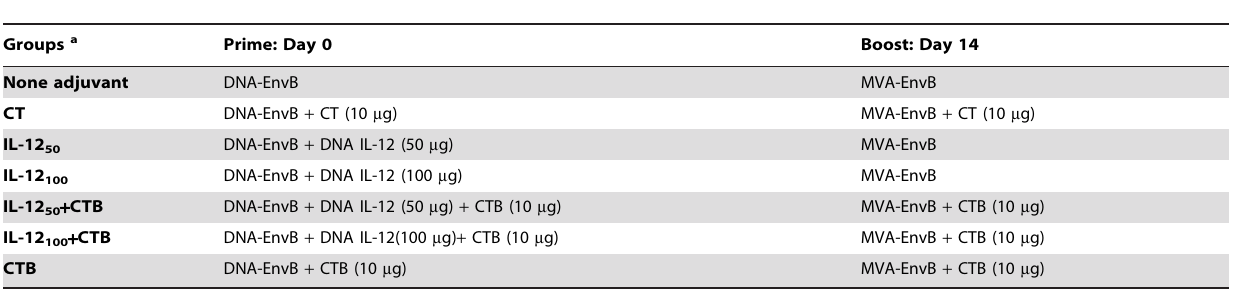
Table 1. Intranasal immunization schemes